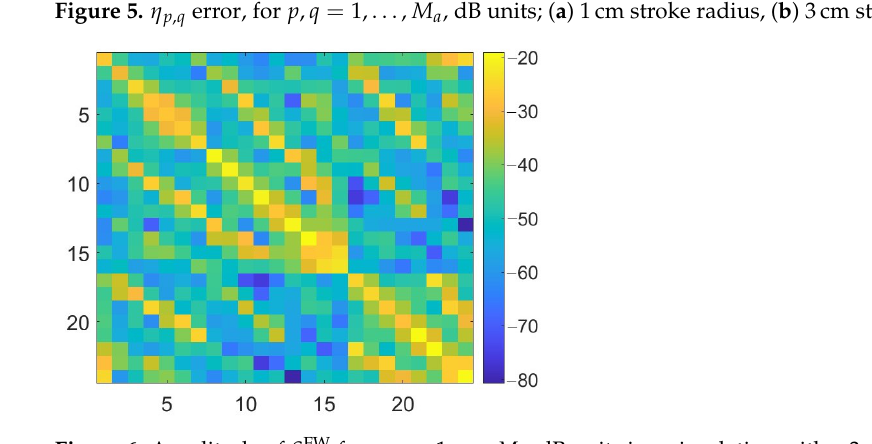
Figure 6. Amplitude of S FW p , q for p , q = 1, . . . , M a , dB units in a simulation with a 3cm stroke